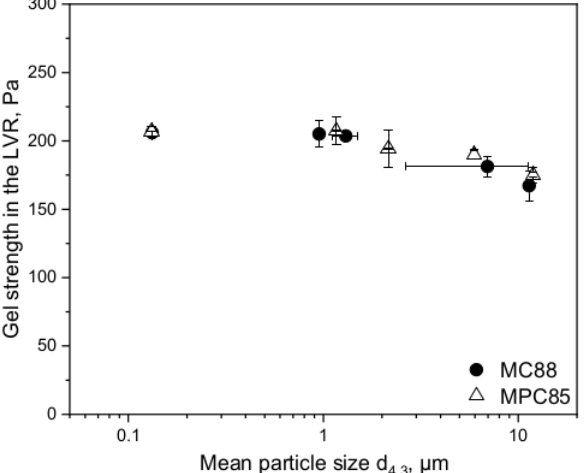
Figure 4. Gel strength in the linear viscoelastic region (LVR) of skim milk enriched with MC88 and MPC85 as a function of mean particle size d 4,3 . Particle sizes decrease with increasing shear